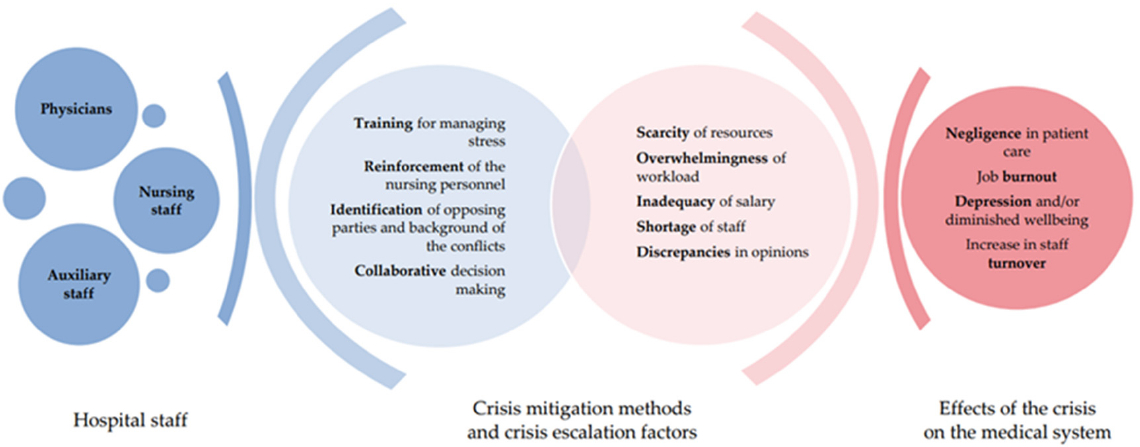
Figure 3. Cause and effect relationship in conflict management.